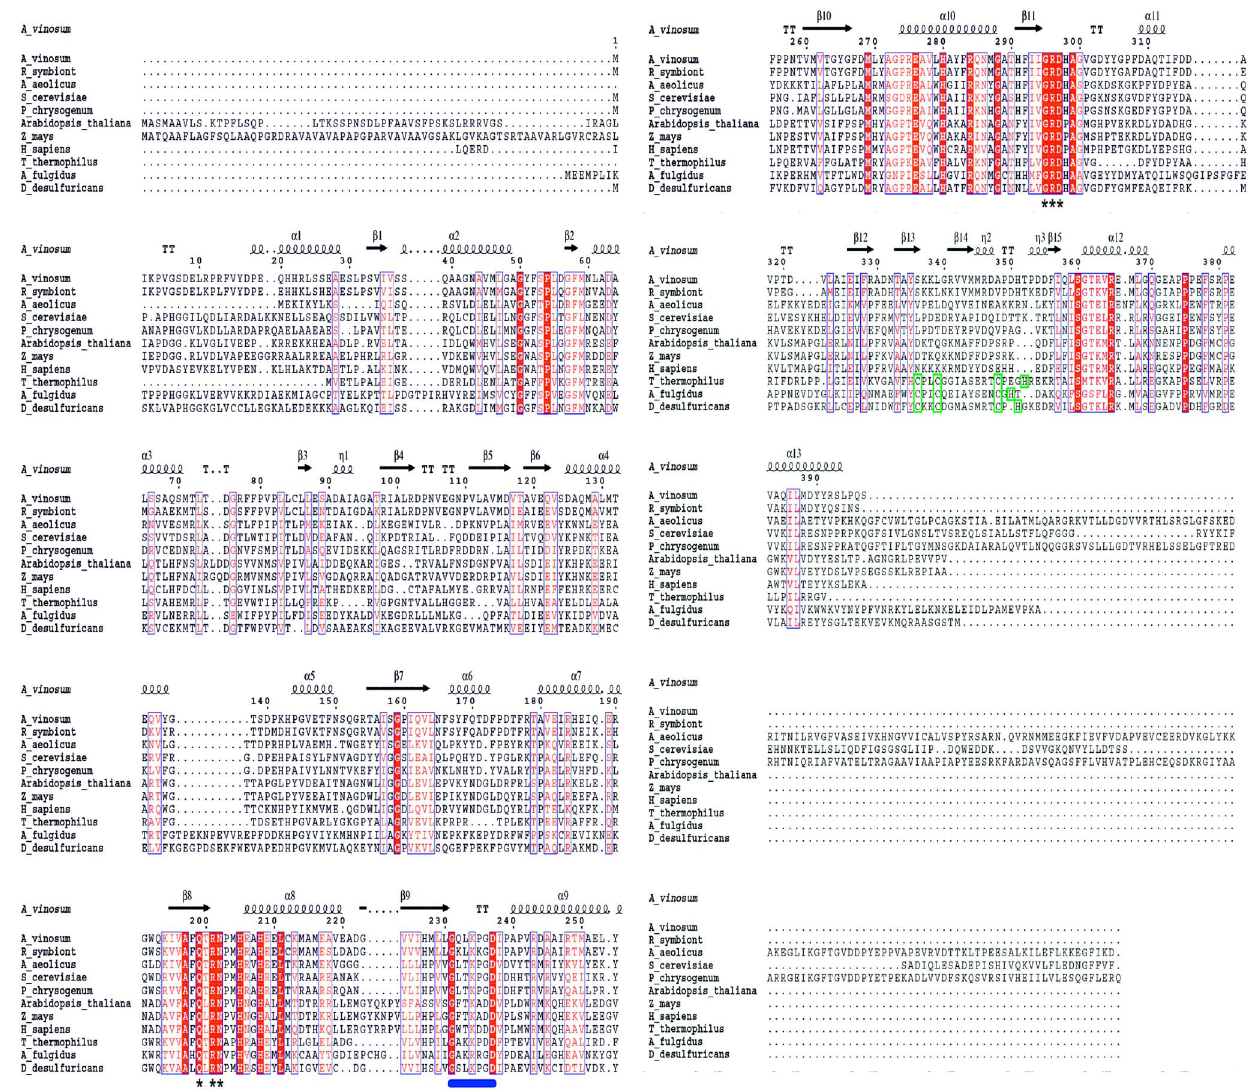
Figure 5. Sequence alignment of ATP sulfurylases from sulfur oxidizing and sulfate assimilating and dissimilating organisms. Residues of the highly conserved RNP and GRD motif and the mobile loop are indicated by asterisks and a blue stripe, respectively. The three cysteines and one histidine of the conserved zinc-binding motif are marked with red boxes. The secondary structure symbols are illustrated according the ATPS structure of A. vinosum . The alignment figure was made using the programs ClustalX [50] and ESPript [51]. Species: Allochromatium vinosum DSM 180 T (A_vinosum, Alvin_1117, ADC62057), ‘‘ Candidatus Endoriftia Persephone’’ (R_symbiont, PDB: 1JHD_A), Aquifex aeolicus VF5 (A_aeolicus, PDB: 2GKS_A), Saccharomyces cerevisiae (S_cerevisiae, Met3p, AAU09752), Penicillium chrysogenum (P_chrysogenum, MET3_PENCH, Q12650), Arabidopsis thaliana (Arabidopsis_thaliana, AAA21570), Zea mays (Z_mays, NP_001104877), Homo sapiens (H_sapiens, PDB: 2QJF_A), Thermus thermophilus (T_thermophilus, YP_004282.1), Archaeoglobus fulgidus (A_fulgidus, SAT_ARCFU, SP: O28606.2), Desulfovibrio desulfuricans ATCC 27774 (D_desulfuricans, YP_002479044.1).